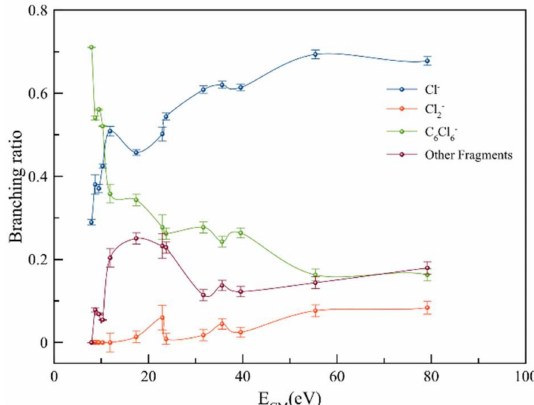
Figure 2. Hexachlorobenzene BRs (fragment anion yield/total anion yield) of C 6 Cl 6 − , Cl 2 − and Cl − ions formed as a function of the collision energy in the center-of-mass (CM) frame. Error bars are related to the experimental uncertainty associated with the ion yields. The lines serve purely to guide the eye.